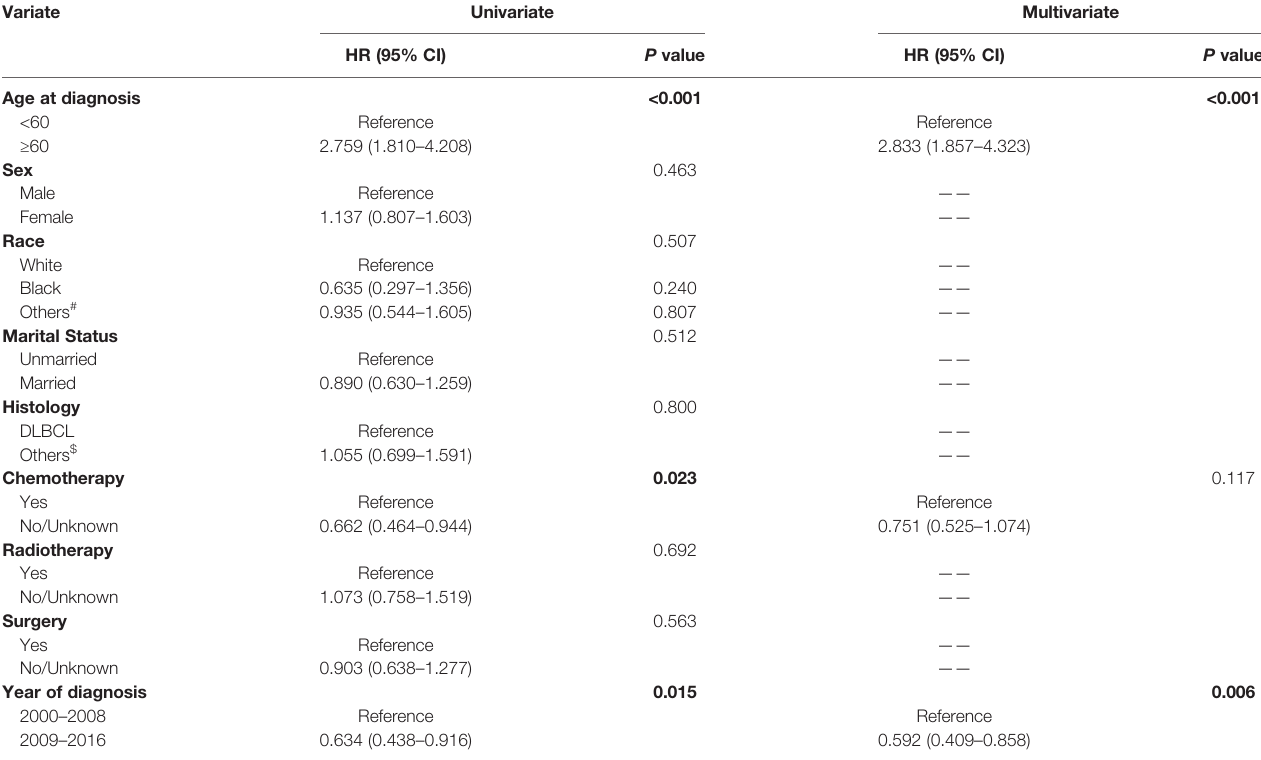
TABLE 3 | Competing-risks regression analyses of CVD in PCNSL patients. Variate Univariate